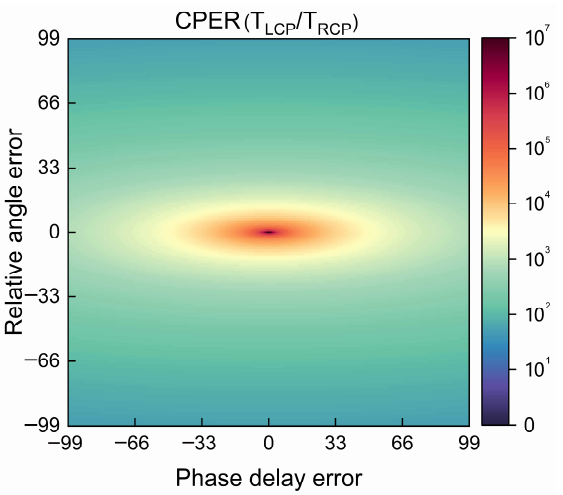
Figure 12. Effects of the relative angle error and phase-delay error on the measurement results of the circular polarization extinction ratio.